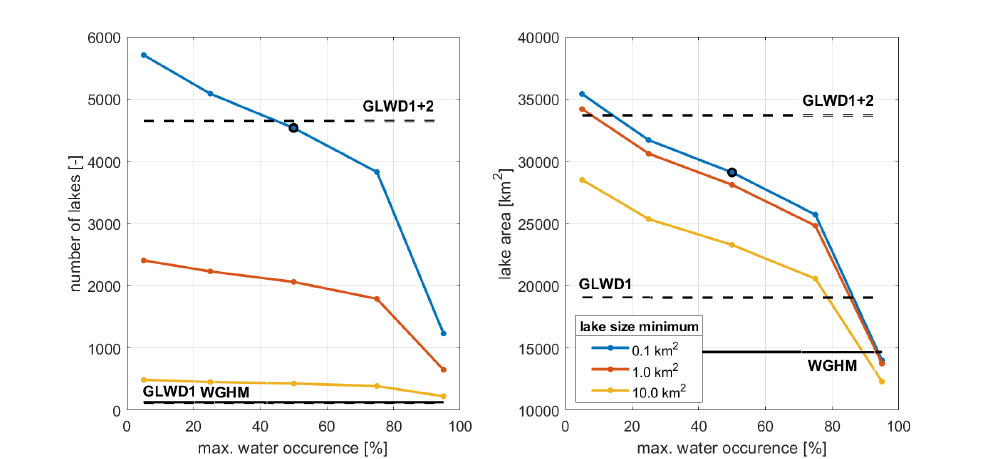
Figure 3. Number (left) and total area (right) of detected lakes in the Mississippi River Basin (MRB) depending on the adopted water occurrence probabilities for three different minimum lake sizes (blue: <0.1 km 2 ; red: <1 km 2 ; orange: <10 km 2 ). The blue dots with a black edge indicates the results for a 50% water occurrence probability and a 0.1 km 2 lake size limit, which are given in the text. Dashed black lines show the number and area from the Global Lakes and Wetlands Database (GLWD) (lower line: GLWD Level 1 only; upper line: GLWD Level 1+2). Solid black lines indicate numbers from the WaterGap Global Hydrology Model